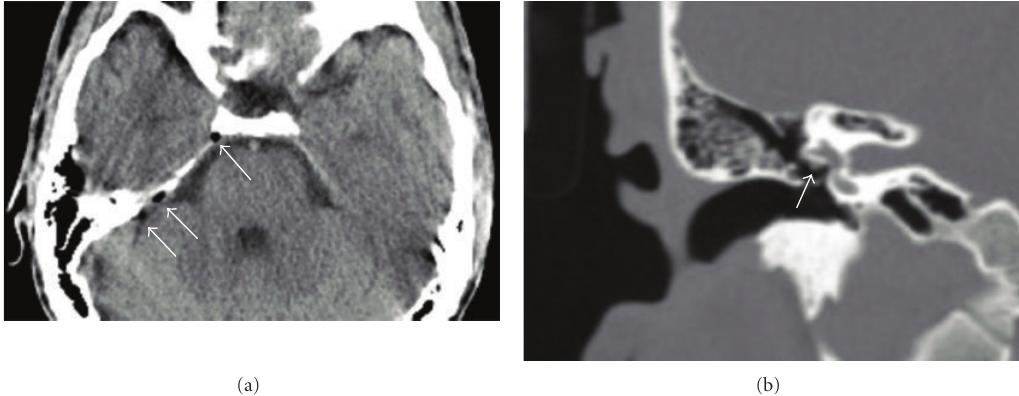
Figure 1: (a) Brain CT (axial section) free air (arrow) is observed in the subdural space. (b) Temporal bone target CT (sagittal section); the tympanic segment of the facial nerve (arrow) appears to be directly exposed to the tympanic